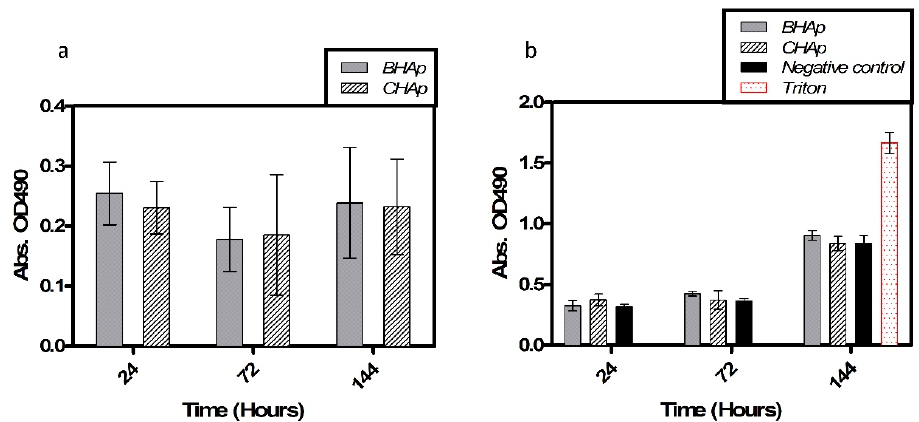
Figure 9. Cell viability of hFOB cells after 24 h, 72 h and 144 h of exposure to samples: ( a ) MTS assay; and ( b ) cytotoxicity by LDH assay. Data were normalized and compared (mean, SD, n = 6) using a two-way ANOVA, no significant differences considering p < 0.05.